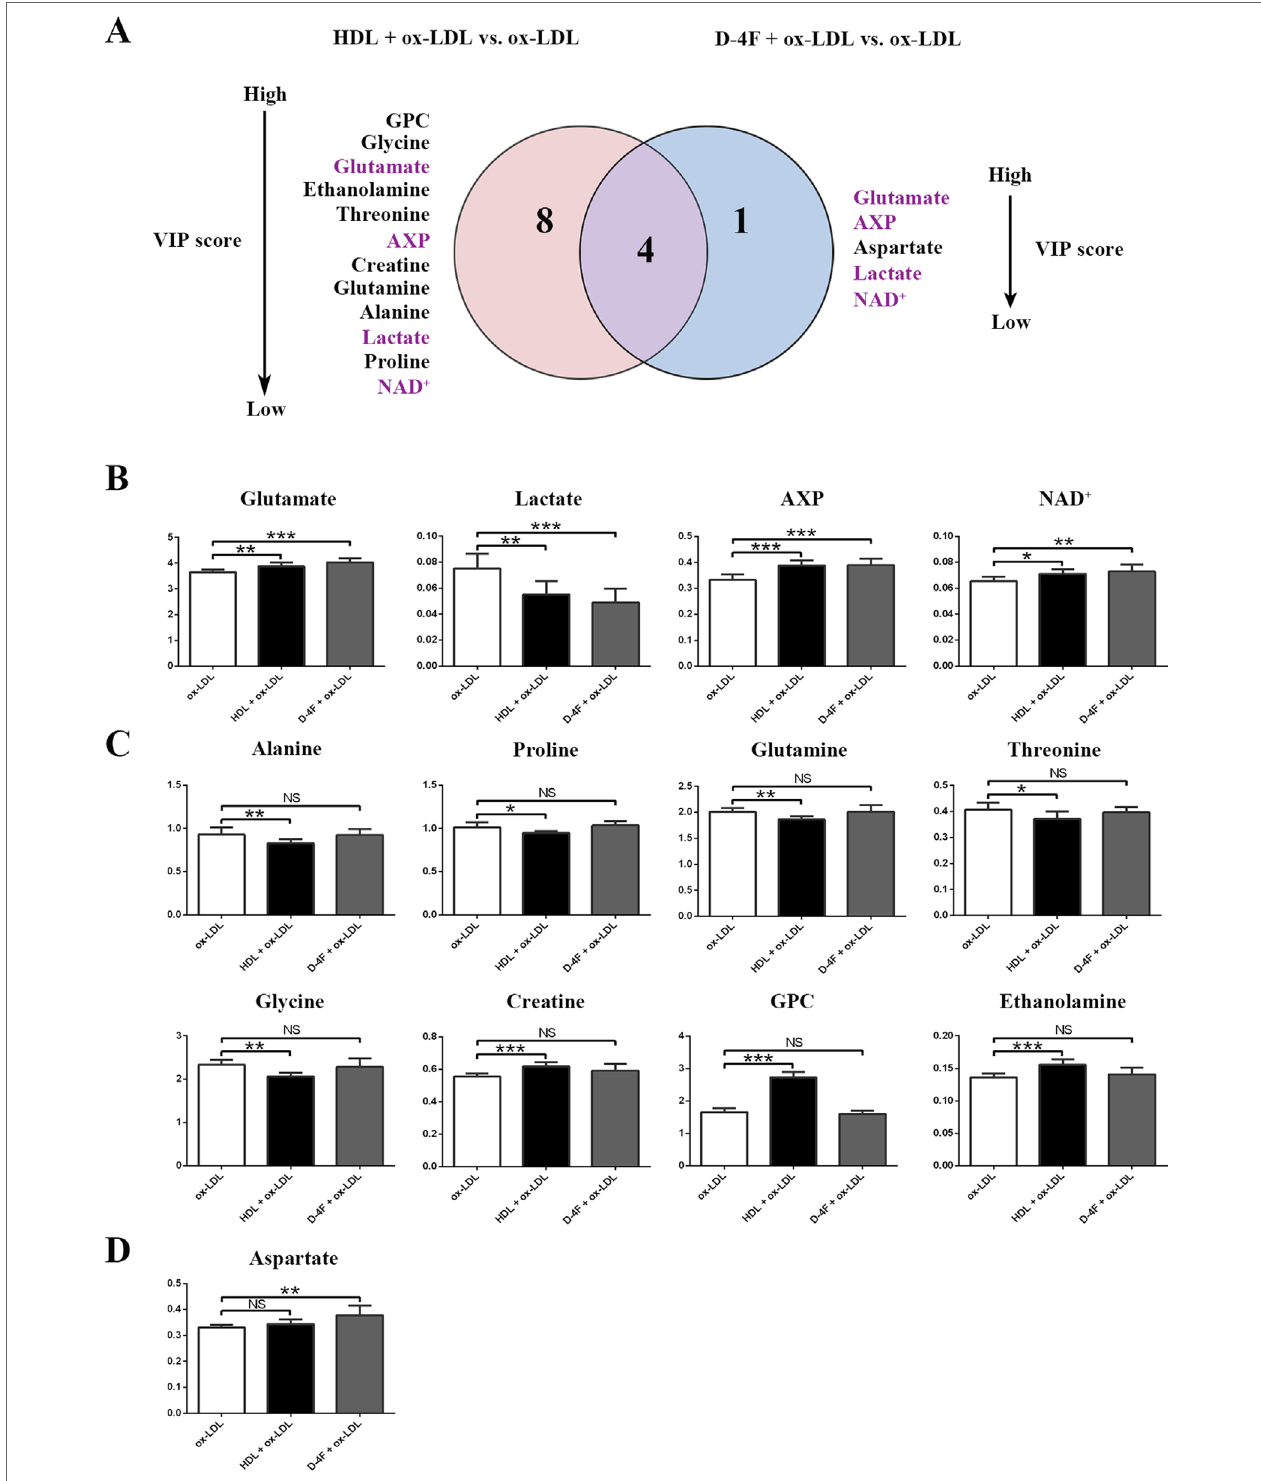
FIGURE 6 | Quantitative analysis of characteristic metabolites significantly responsible for distinguishing the metabolic profiles among ox-LDL, HDL + ox-LDL, and D-4F + ox-LDL groups. (A) Venn diagram of characteristic metabolites generated from comparisons of the metabolite levels for HDL + ox-LDL vs . ox-LDL (left-hand circle), and D-4F + ox-LDL vs . ox-LDL (right-hand circle). (B – D) Histograms of the relative levels of the metabolites in the four groups: (B) four common characteristic metabolites shared by both pair-wise comparisons (HDL + ox-LDL vs . ox-LDL; D-4F + ox-LDL vs . ox-LDL); (C) eight characteristic metabolites screened specifically for the comparison of HDL + ox-LDL vs. ox-LDL; (D) one characteristic metabolite screened specifically for the comparison of D-4F + ox-LDL vs. ox-LDL. Statistical significances: NS, p ≥ 0.05; * p < 0.05; ** p < 0.01; *** p <